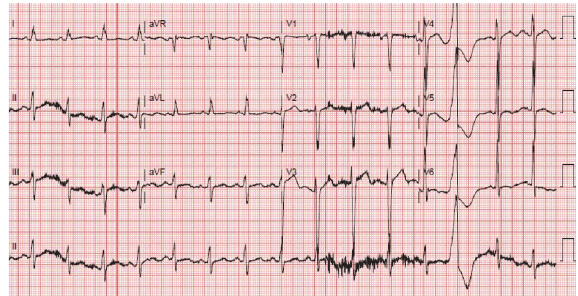
Figure 1: EKG showing sinus rhythm with premature ventricular complexes and nonspecific T wave changes.